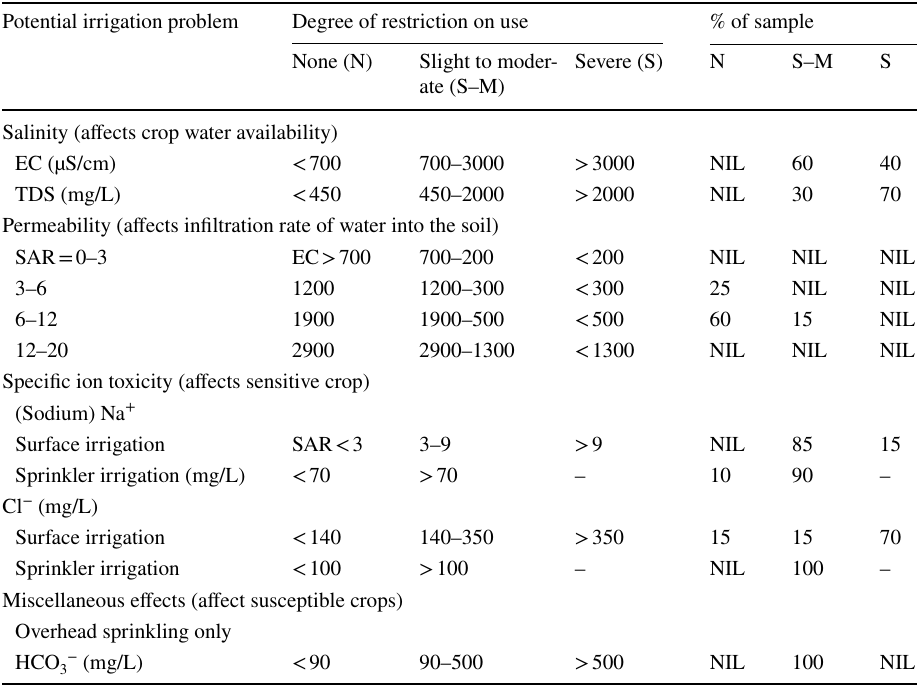
Figures are in percentage of samples in the particular categories of degree of problem and evaluated using EC and SAR of the average value of 18.41% (Table 6). Based on WHO criterion for assessing the suitability of water for irrigation based on the permeability index (WHO 2004), the permeability index values for 80% of the groundwater samples fall under class I (PI in range of 1–24%) and 20% of the samples fall under class II category (PI ranged in 25–75%).